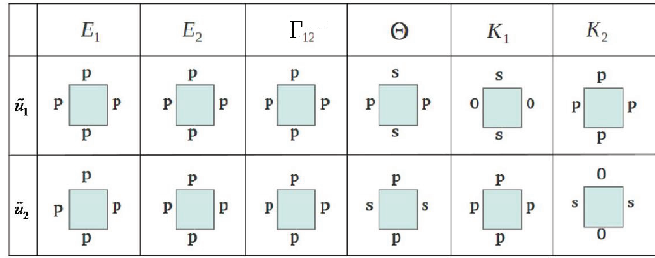
Figure 1: Boundary conditions to impose on the UC to evaluate the perturbation fields, derived in [7]. Comparison between Procedures A, B and